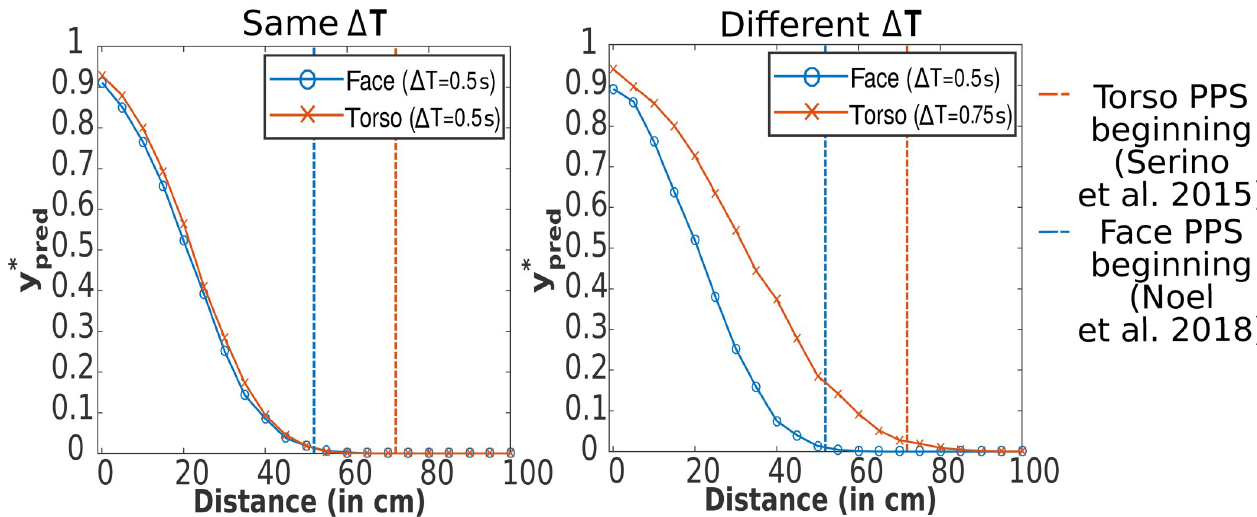
Fig 9. Modulation of PPS for face and torso in 3D model by prediction time step. Dependency between distance of stimuli from body and the mean of 1000 impact predictions y � calculated by the 3D model (see Section Extension to 3D space) for each distance and for PPS representation around the face (body part pred size [25cm, 25cm]) and trunk (body part size [50cm, 50cm]). Baseline parameters (see Table 1) were used. Horizontal and vertical uncertainties were set to s 2 ; 3 ¼ 5 cm ; s 2 ; 3 ¼ 5 cm = s . For a detailed experiment description see Fig 8. (Left) Prediction time step Δ T is same for both body parts (baseline value). The x v vertical and horizontal uncertainties are not large enough to cause different sizes for both body parts. (Right) The prediction time step is higher for the torso ( Δ T = 0.75 s ) than for the face. In this setting, the PPS beginnings of both body parts fit roughly the empirical estimations. The vertical dashed lines correspond to the PPS beginning estimations from [14, 33]. See S5 Fig for a version with FN = FP = 1.